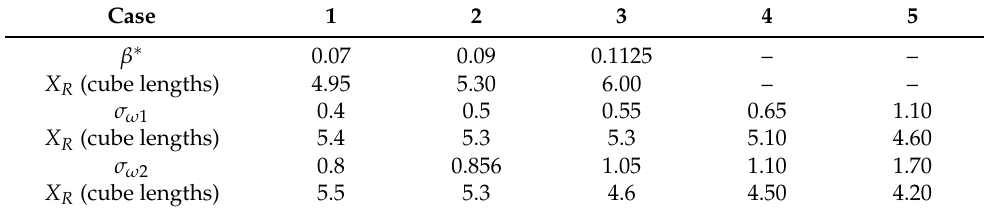
Table 3. Results from turning on modeling coefficients using the SST URANS Turbulence